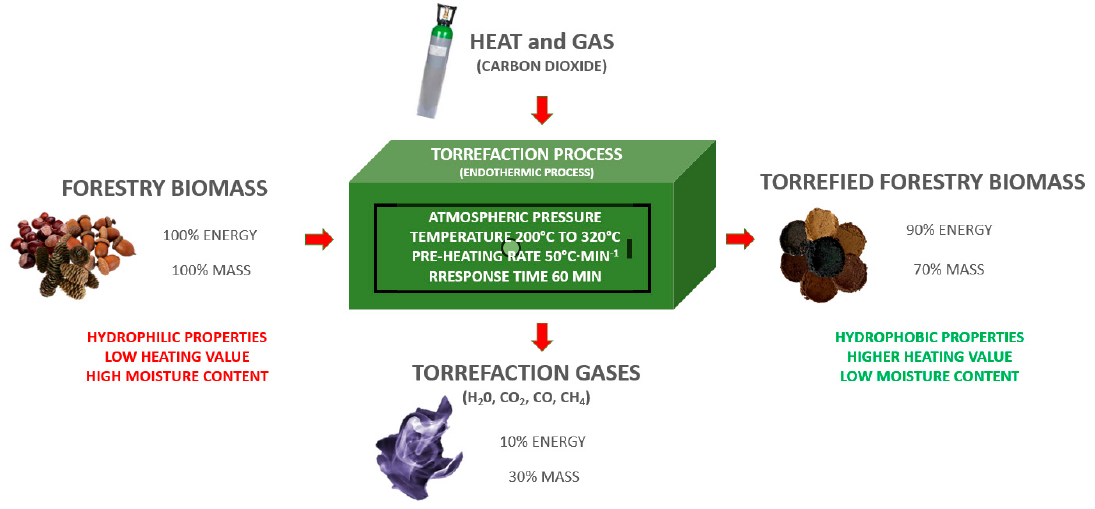
Figure 4. Forestry biomass (horse chestnuts, oak acorns, spruce cones) processing in the torrefaction process.